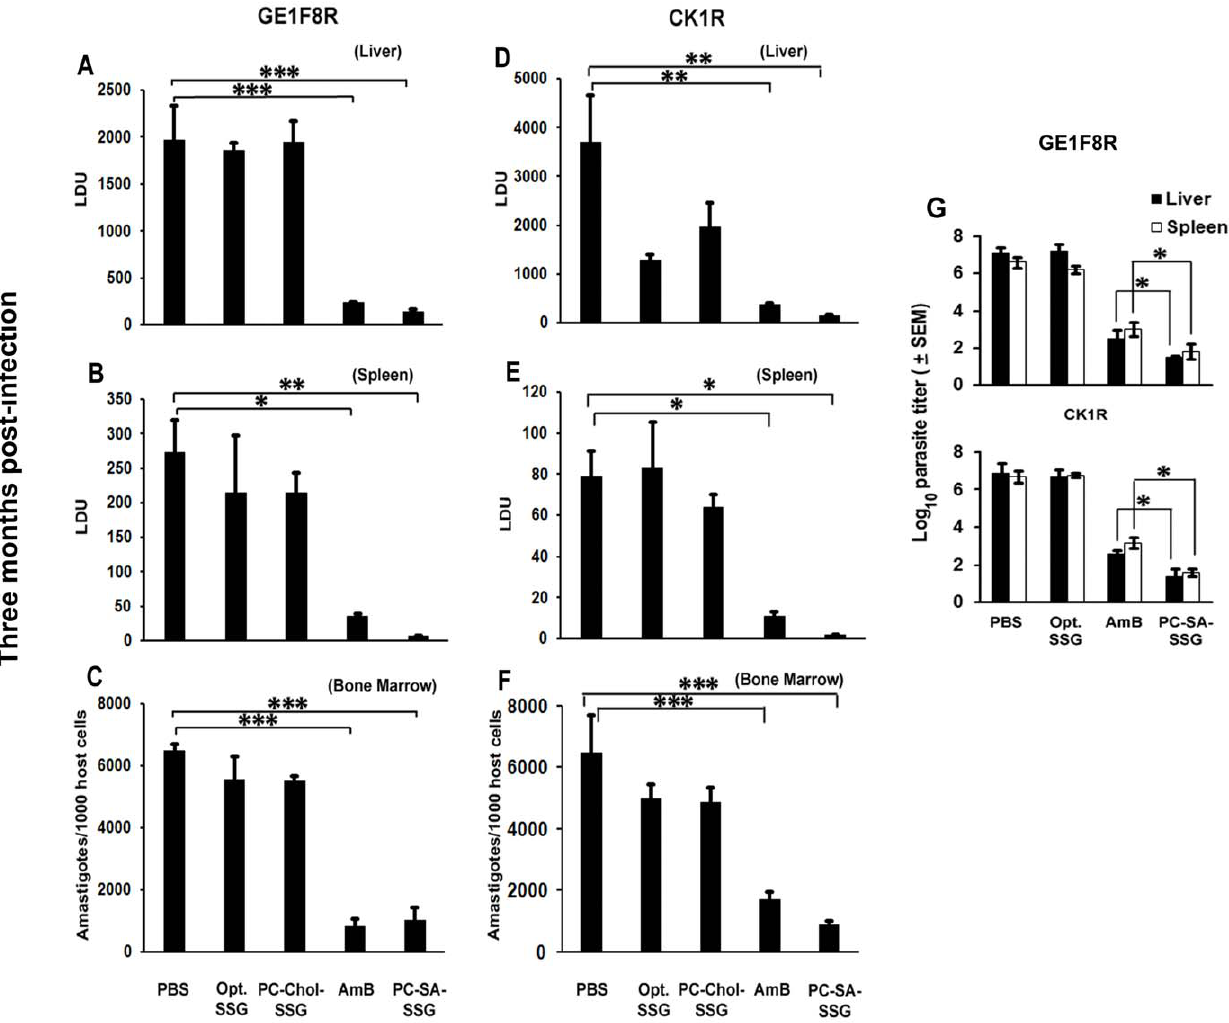
Figure 1. Parasite burden in treated BALB/c mice after L.donovani challenge infection. Parasite loads of liver, spleen, and bone marrow in murine model of established visceral leishmaniasis after treatment with 300 mg/kg of free sodium stibogluconate (SSG), 12 mg/kg of SSG entrapped in phosphatidylcholine-stearylamine (PC-SA) or phosphatidylcholine-cholesterol (PC-Chol) liposomes and 2 mg/kg amphotericin B (AmB). Mice were infected with L. donovani amastigotes of either GE1F8R or CK1R strains. At 8 week postinfection (p.i.) mice were treated with a single dose of various drugs by intravenous injection. Mice were sacrificed after 4 weeks of treatment for determination of (A, D) liver, (B, E) spleen, and (C, F) bone marrow parasite loads. Untreated, infected mice were used as controls. Liver and spleen parasite burden were determined by stamp-smear method and expressed as Leishman Donovan Units (LDU), and bone marrow parasite load in cell smear prepared from femur bone marrow and expressed as amastigotes/1000 bone marrow nuclei. Data represent mean 6 SEM (n=5 mice per group), representative of two similar experiments. * p , 0.05; ** p , 0.01; *** p , 0.001. (G) Eight week infected mice received optimal SSG, PC-SA-SSG and AmB. Parasite burden determined 12 weeks following infection reflects the mean log 10 parasite burden 6 SEM determined by the limiting dilution assay (LDA) (n=5 mice per group) with PBS treated group as control. Data are representative of two similar experiments. * p , 0.05 compared to AmB therapy.